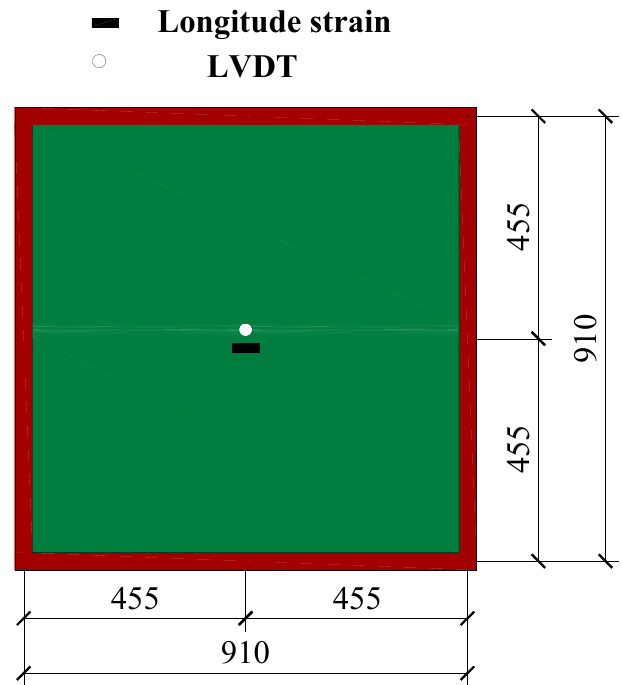
Figure 5. LVDT for the out-of-transverse deflection scheme. Table 1. Details of the specimens.